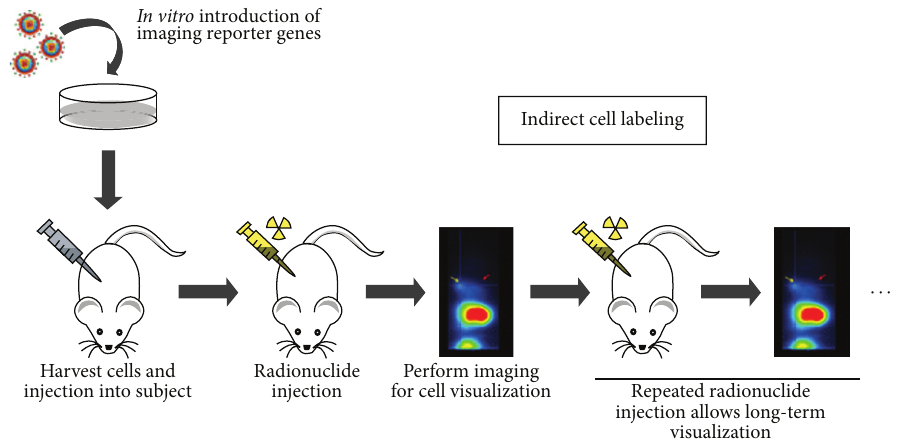
Figure 2: Schematic overview of the steps involved in indirect cell labeling. First, imaging reporter gene expression is induced in vitro in host cells. Reporter gene expressing cells are harvested and injected into a subject. In a next step, the respective radiotracer is injected and imaging can be performed to determine the localization of the cells. Repetitive injection of the radiotracer allows for repetitive imaging and thus long-term visualization of the engrafted cells